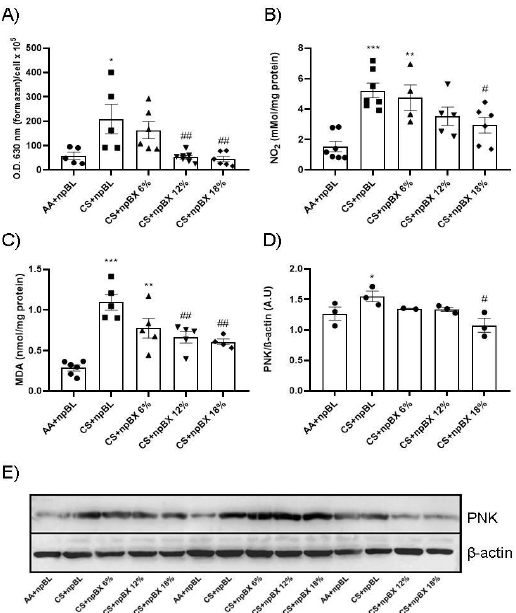
Figure 6. Effects of bixin-loaded nanoparticles on markers of the redox homeostasis in the lung. ( A ) Total ROS in BALF determined by NBT method. ( B ) Nitrite (NO 2 ) levels in BALF as a nitric oxide (NO) marker measured by Griess assay. ( C ) Lung homogenate levels of MDA as a lipid oxidative damage marker. ( D ) Densitometry of Western blotting ( n = 3) results for PNK expression (in lung homogenates). ( E ) Representative image of Western blotting for PNK and β -actin. * p < 0.05, ** p < 0.01, *** p < 0.001 when compared to AA + npBL; # p < 0.05 and ## p < 0.01 when compared to CS +